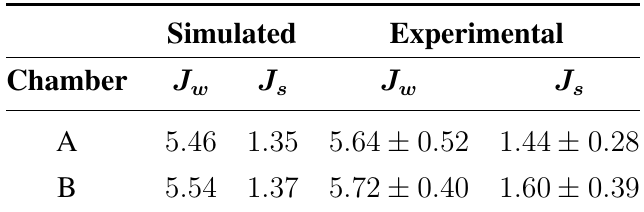
Table 2. Experimental and simulated water and solute fluxes in chambers A and B. Experiments as well as simulations were carried out using a 1 M draw solution, a pure water feed solution, and a cross-flow of 50 mL min − 1 . The units of J and kg (m 2 h) − 1 , respectively.